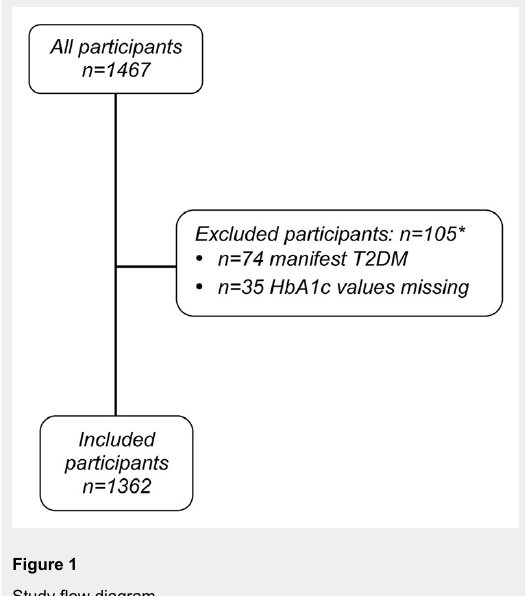
Study flow diagram. In addition to the exclusions for known diabetes mellitus, we had to exclude subjects in whom the relevant laboratory tests were not available. * Four participants fulfilled both exclusion